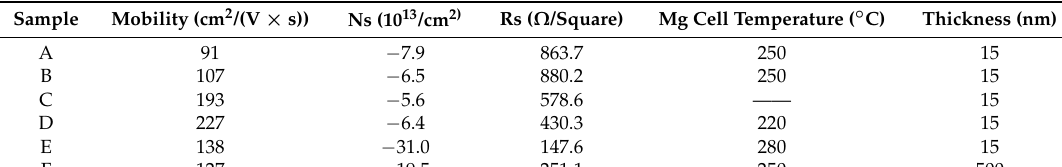
Table 1. The parameters and Hall measurement results of all samples.